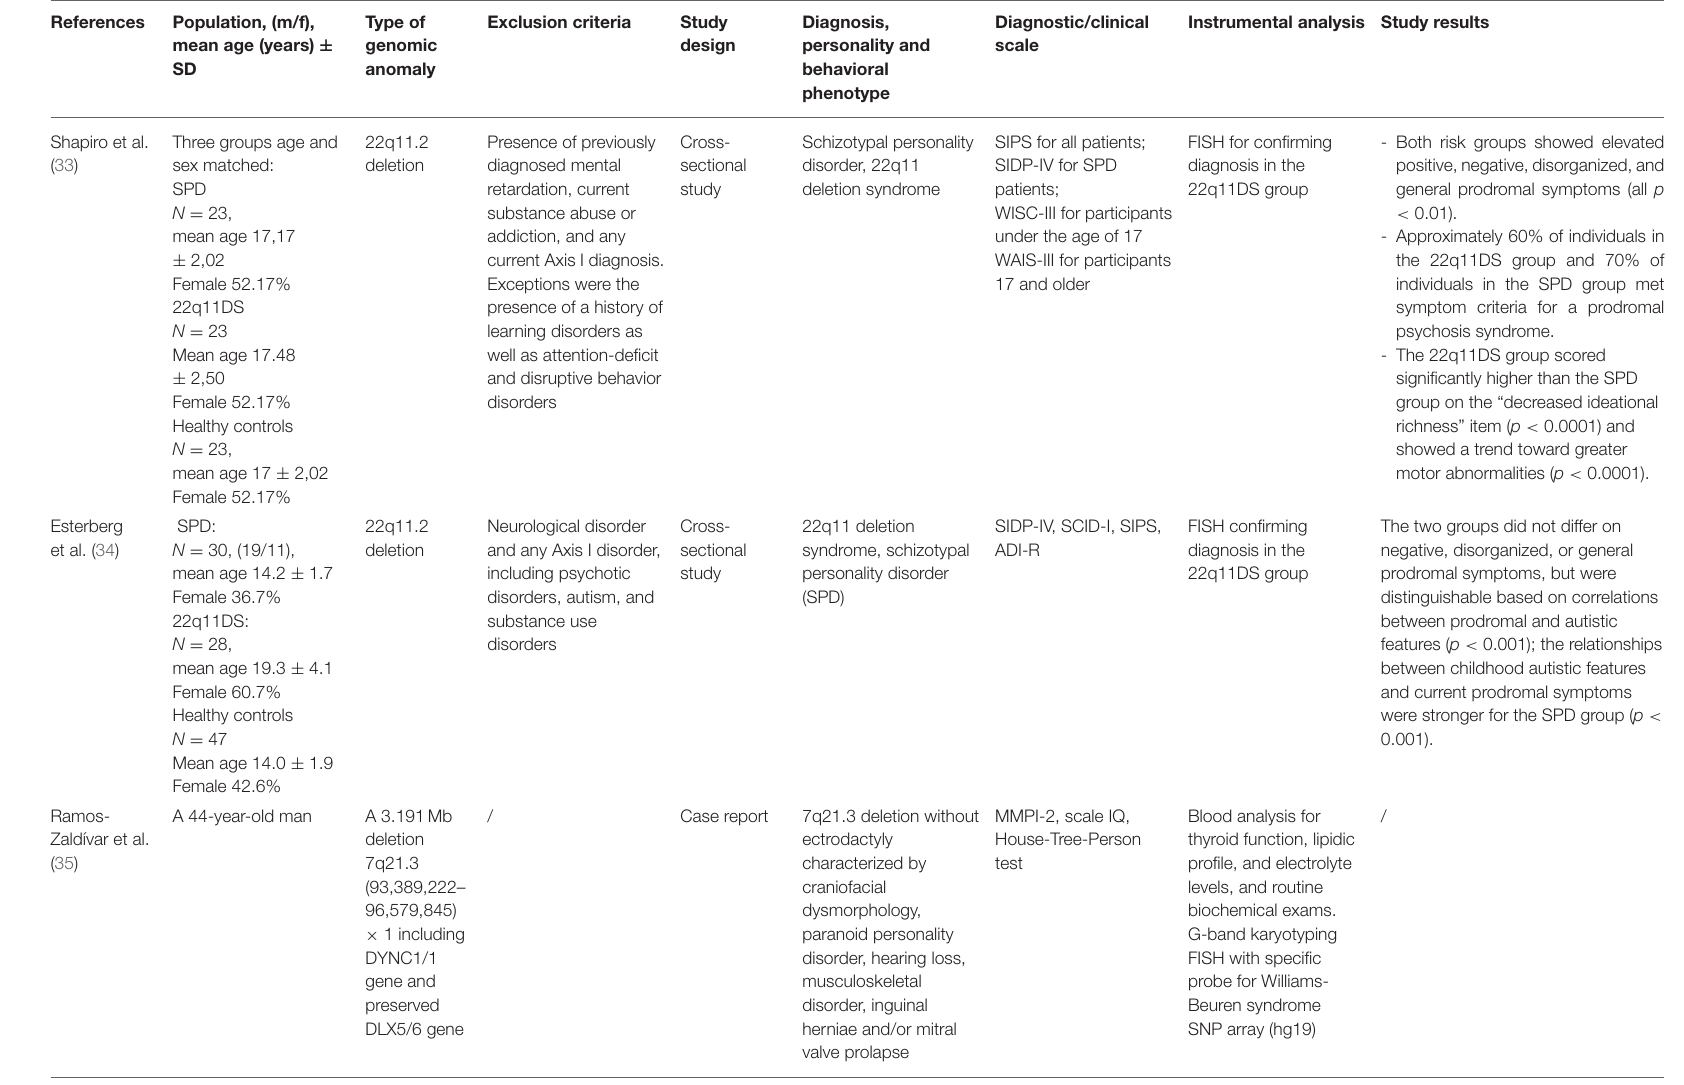
TABLE 1 | The association between chromosomal rearrangements and